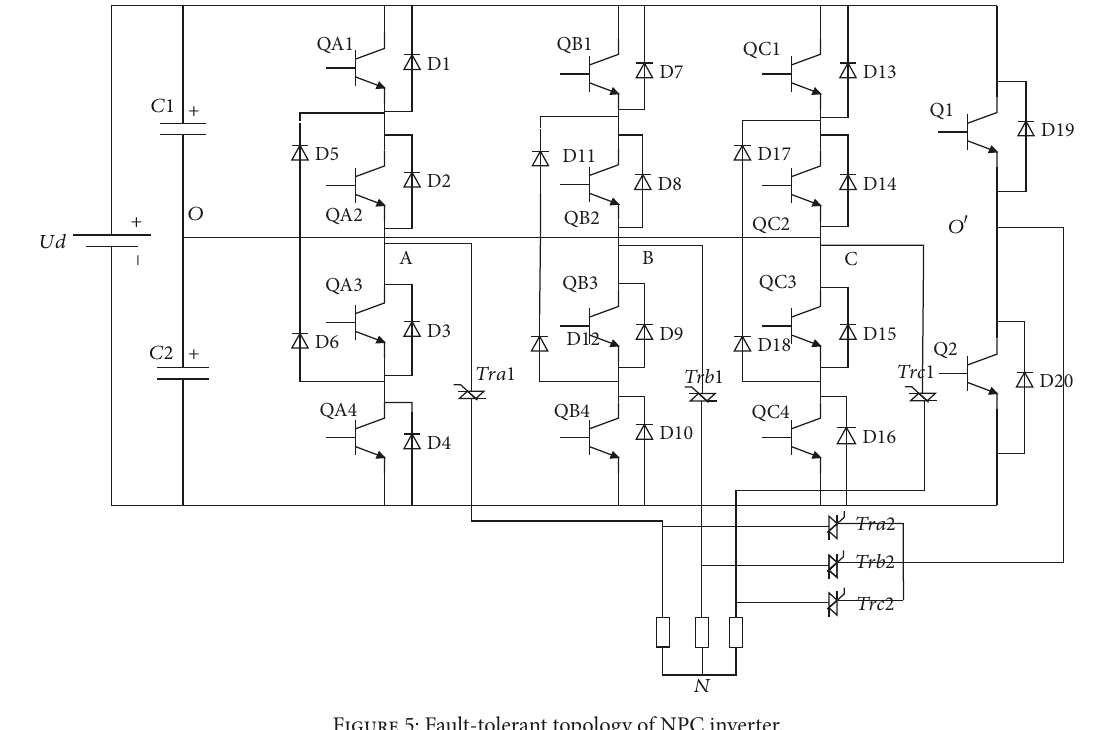
Figure 5: Fault-tolerant topology of NPC inverter. Table 2: Substitution law of voltage